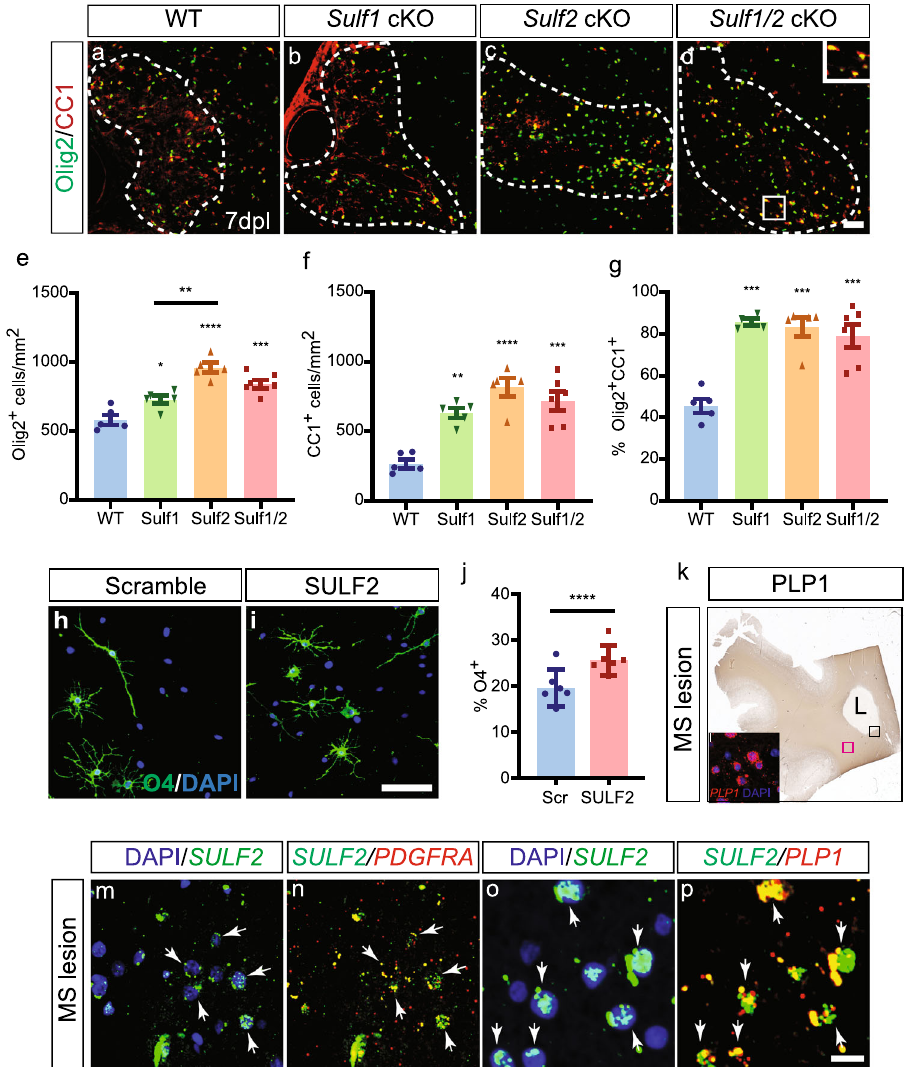
Fig. 3 Sulf2 deletion results in improved oligodendrocyte recruitment and differentiation and is upregulated in chronic active MS lesions. Tamoxifen- dependent OPC-speci fi c ablation of either Sulf1 , Sulf2 alone, or both Sulf1/2 in NG2 + OPCs was initiated prior to demyelination. Control animals (lacking cre) were treated in an identical manner. Wide fi eld immuno fl uorescence for Olig2 (green) and CC1 (red) at 7 d.p.l. ( a – d ). The density (cells/mm 2 ) of Olig2 + oligodendrocytes lineage cells ( e ), Olig2 + CC1 + postmitotic oligodendrocytes ( f ) and percentage of CC1 + oligodendrocytes ( g ) was quanti fi ed ( n = 5 for each group except n = 6 for Sulf1/2 cKO). Mean ± SEM is shown. Two-way ANOVA for Sulf1 and Sulf2 genotypes. Holm – Sidak post-test vs. wild- type control *, **, ***, and *** indicates p < 0.05, 0.01, 0.001, and 0.0001, respectively. h – j Human primary OPCs infected with lentiviral SULF2 knockdown (KD) or scrambled control cultured in mitogen-free conditions for 4 days. Oligodendrocyte differentiation assessed by O4 immunocytochemistry (green) and DAPI (blue) ( h , i ). j SULF2 KD accelerated O4 + oligodendrocyte differentiation (**** p < 0.0001 paired t test, n = 6 fetal human samples). k PLP1 immunohistochemistry of chronic active human MS lesion and surrounding normal white matter (NAWM). l RNAscope for PLP1 mRNA in NAWM (pink box in k ). m – p Confocal-based RNAscope in situ hybridization at lesion border (black box in k ) for SULF2 (green), PDGFRA (red, n ), and PLP1 (red, p ) mRNA. Arrow represents colocalization of SULF2 with PDGFRA and PLP1 mRNAs. Scale: 20 µ m ( a – d , m – p ), and 50 µ m ( i , j (Fig. 3e). In contrast, individual deletion of either Sulf1 or Sulf2 individual Sulf1/2 cKO on OPC recruitment and differentiation resulted in a highly signi fi cant increase in CC1 + Olig2 + oligo- following demyelination at 7 d.p.l. ( n = 5 – 6 mice per genotype) (Fig. 3a – g). Interestingly, individual Sulf2 deletion resulted in a dendrocyte density relative to wt (two-way ANOVA, main effects signi fi cant increase in the density of Olig2 + oligodendrocyte p < 0.05). A highly signi fi cant interaction of Sulf1 and Sulf2 lineage cells that resembled that of Sulf1/2 double cKOs (Fig. 3e). genotype effect on Olig2 + CC1 + cell density was also consistent with a common function of either gene ( F (1, 17) = 17.4, inter- In contrast, Sulf1 deletion resulted in only a relatively mild action p = 0.0006) (Fig. 3f). Likewise, as an estimate of differ- increase to Olig2 + density relative to control (Fig. 3e). Indeed, two-way analysis of variance (ANOVA) treating Sulf1/2 as entiation, the proportion of CC1 + Olig2 + cells among Olig2 + oligodendrocyte lineage cells was increased following ablation of dependent variables indicated a main effect of Sulf2 but not Sulf1 either Sulf1 or Sulf2 , and comparable with Sulf1/2 double cKO genotype on Olig2 + recruitment ( Sulf2 p < 0.0001, Sulf2 p = 0.67). mice ( F (1, 16) > 10, p < 0.01 for main effects and interaction) Consistent with a shared mechanism, a signi fi cant interaction (Fig. 3g). between Sulf1 and Sulf2 was found ( F (1, 17) = 15.8, p = 0.001)